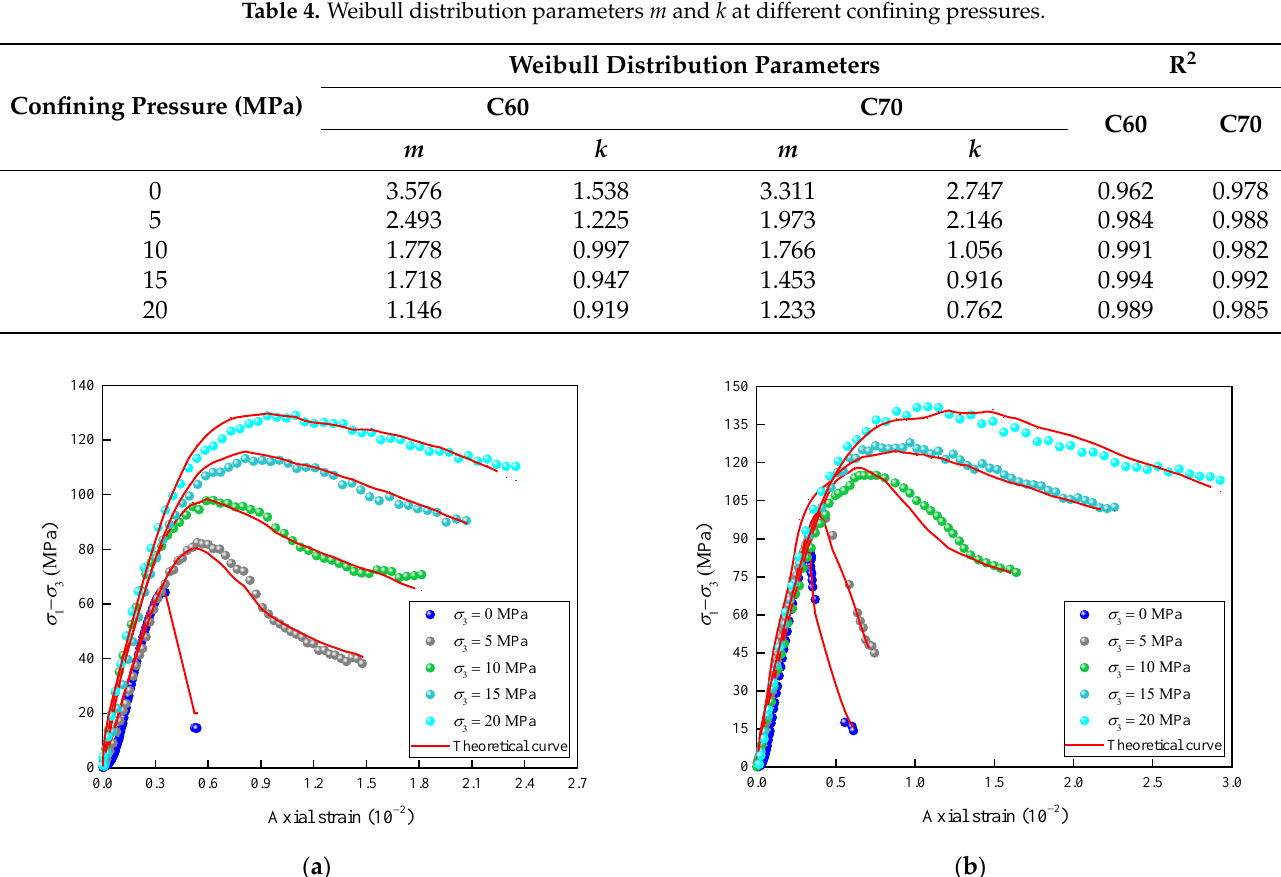
Figure 8. Comparison of constitutive model and test results. ( a ) C60 and ( b ) C70.